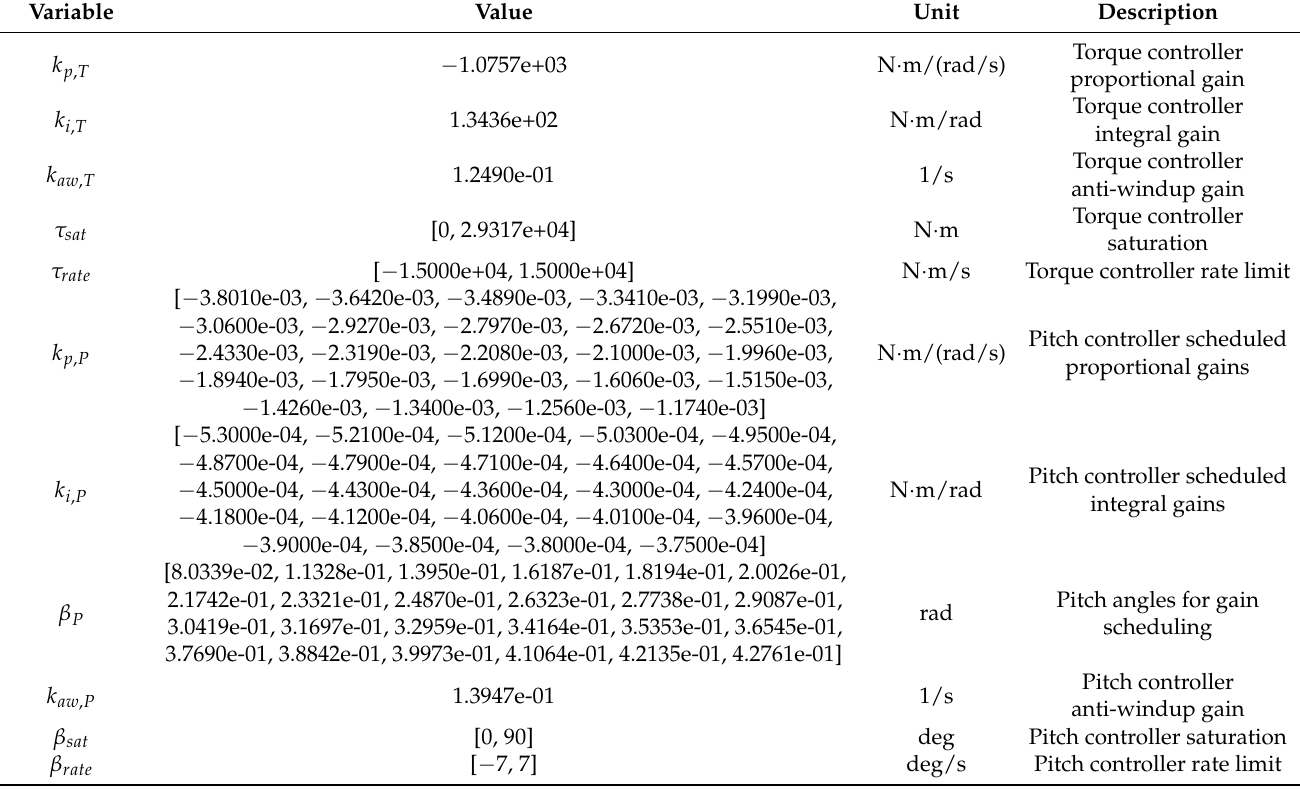
Table A1. ROSCO controller parameters.